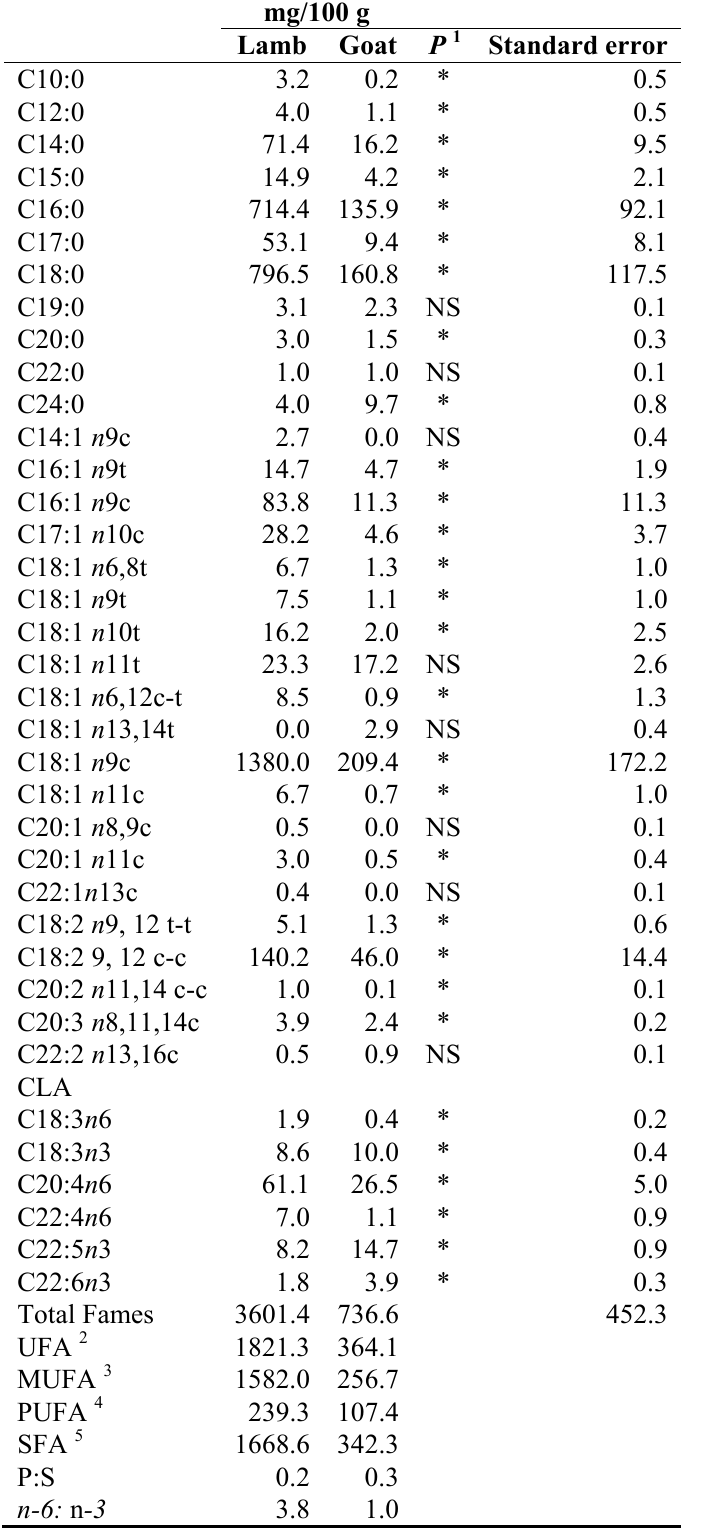
Table 1. Fatty acid content of Longissimus dorsi from Saanen goat and cross Suffolk lamb. mg/100 g Lamb